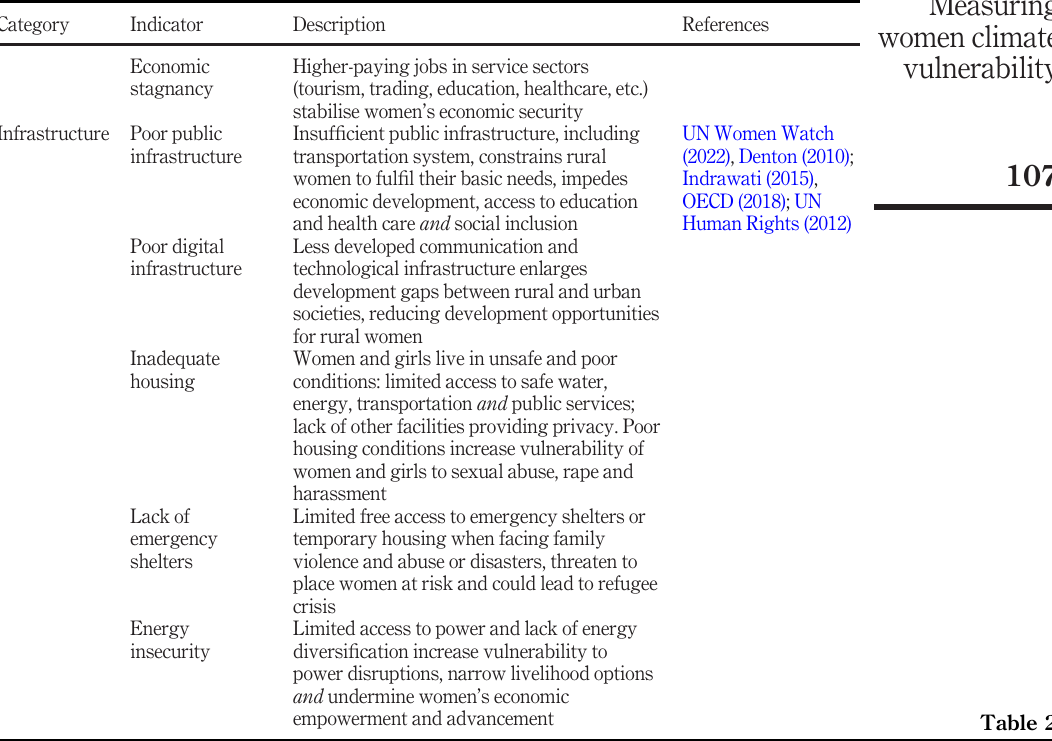
human traf fi cking, to cyber-attacks, pandemics and sudden fi nancial downturns can reduce the ability of women to effectively respond to the climate emergency. Table 3 shows fi ve categories of security and political risk: demographics, governance, stability, cyber security and human security which are made up of 20